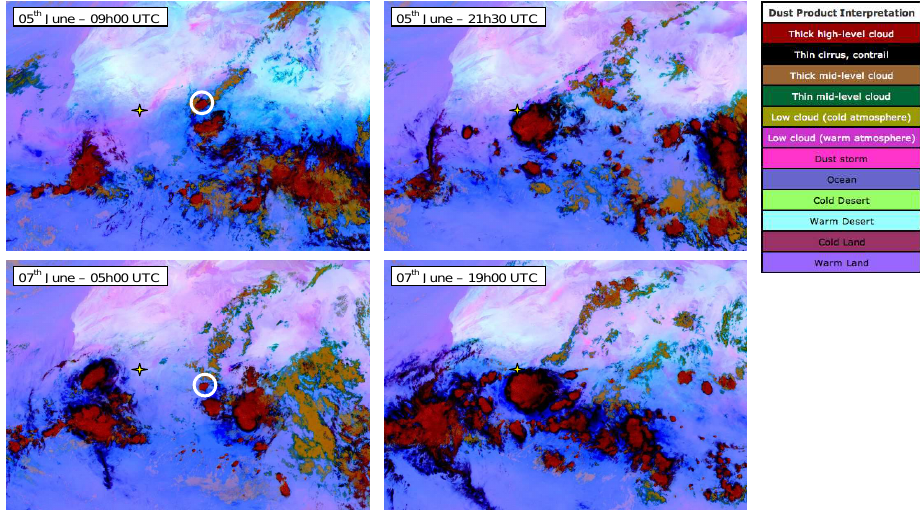
Fig. 14. SEVIRI special dust and pseudo visible products generates using Eumetsat algorithm and data from Eumetsat (infrared channels 12.0, 10.8 and 8.7mm) of the SEVIRI by the RADAGAST Team (Radiative Atmospheric Divergence using Arm mobile Facility, GERB and AMMA stations: on 5 June 2006 at 09:00 and 21:30 and on 7 June 2006 at 05:00 and 19:00. Dust appears pink or magenta and thick high-level clouds appear in red-brown, showing the presence of convective systems. The yellow star represents the station of Cinzana (Mali).